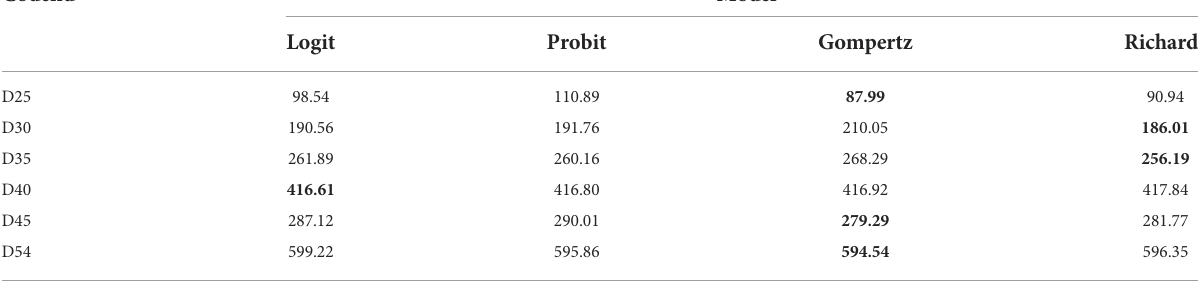
Table 3 Akaike ’ s information criterion values from candidate models for the codends tested.